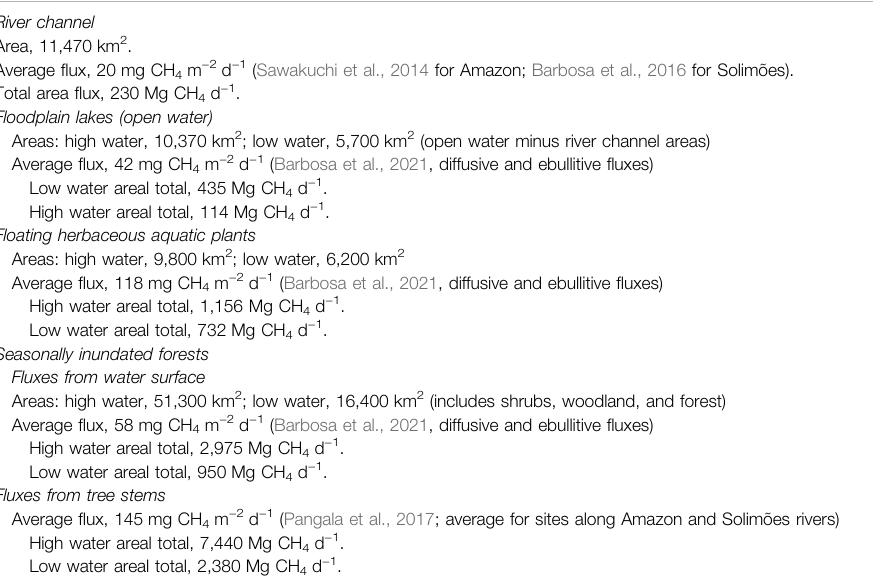
TABLE 1 | Methane emission for reach of the mainstem Solimões-Amazon rivers and fl oodplains from 73.57 o W, 4.5 o S (con fl uence of Marañón and Ucayali rivers) to 51.4 o W, 0.46 o S (Gurupá Island). Areas of aquatic habitats from Melack and Hess (2010) and of rivers from Allen and Pavelsky (2018). Mg = 10 6 g. River channel Area, 11,470 km 2